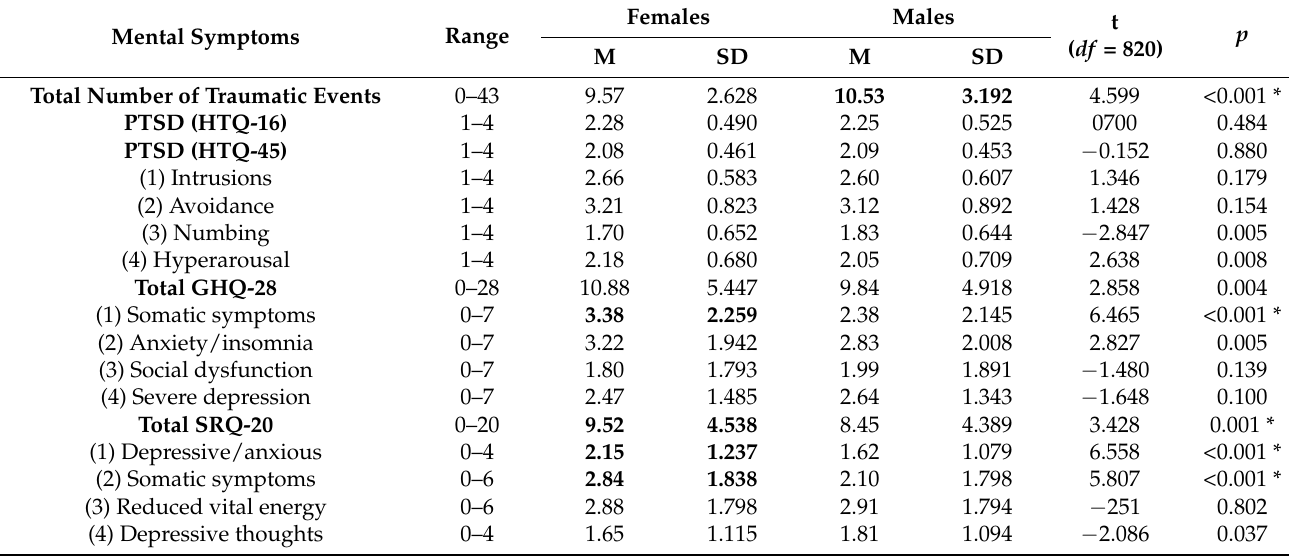
Table 3. Number of traumatic events and prevalence rates of PTSD symptoms and other mental symptoms by